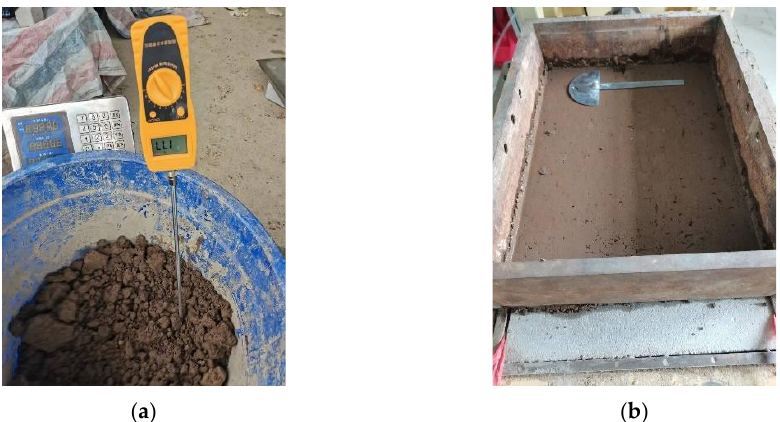
Figure 5. Preparation of the clay sample : ( a ) Moisture content measurement. and ( b ) Clay box.